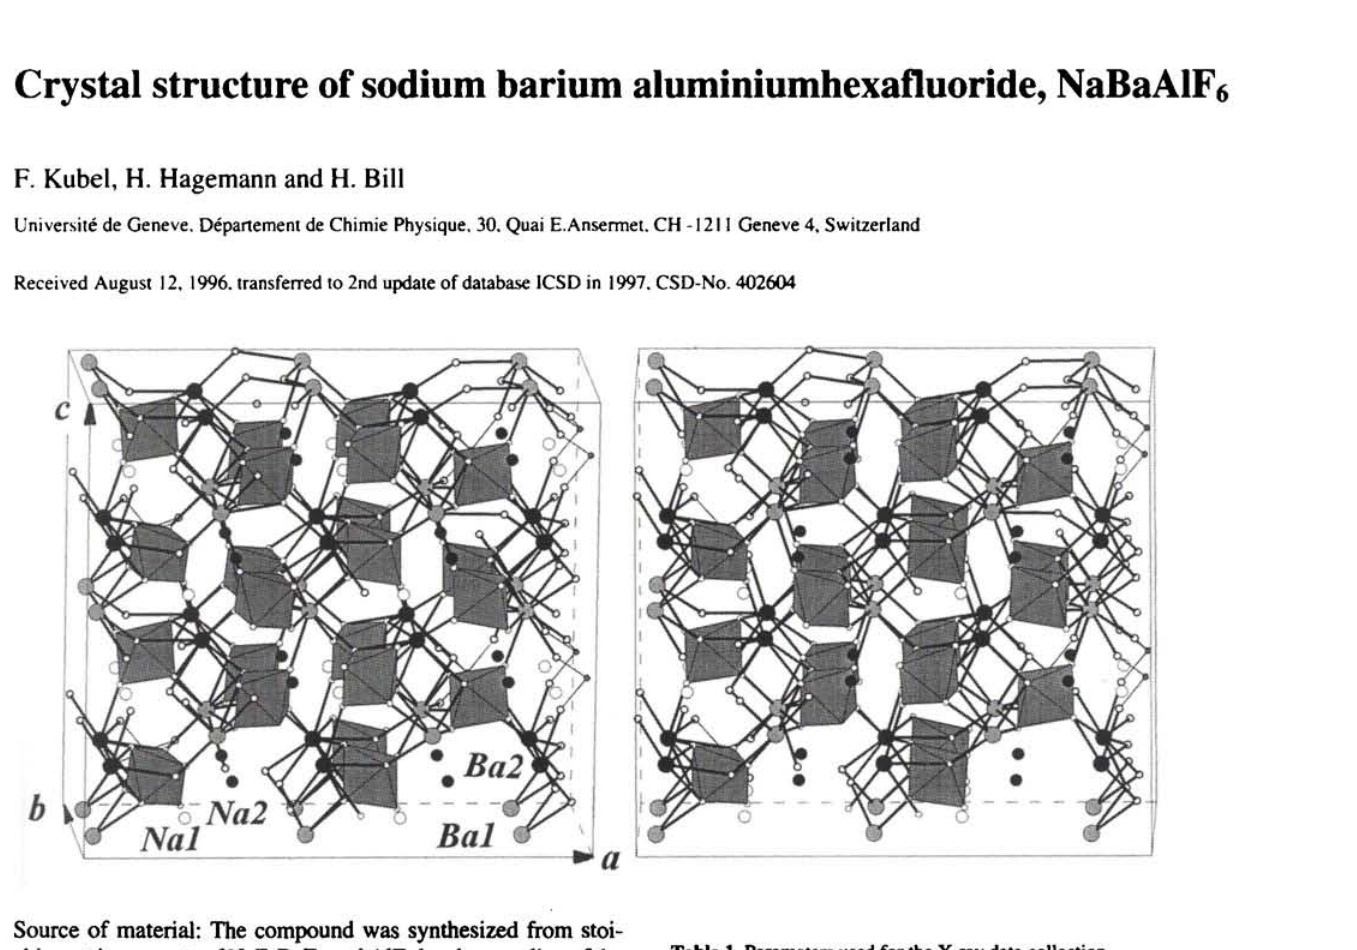
Table 1. Parameters used for the X-ray data collection Crystal: